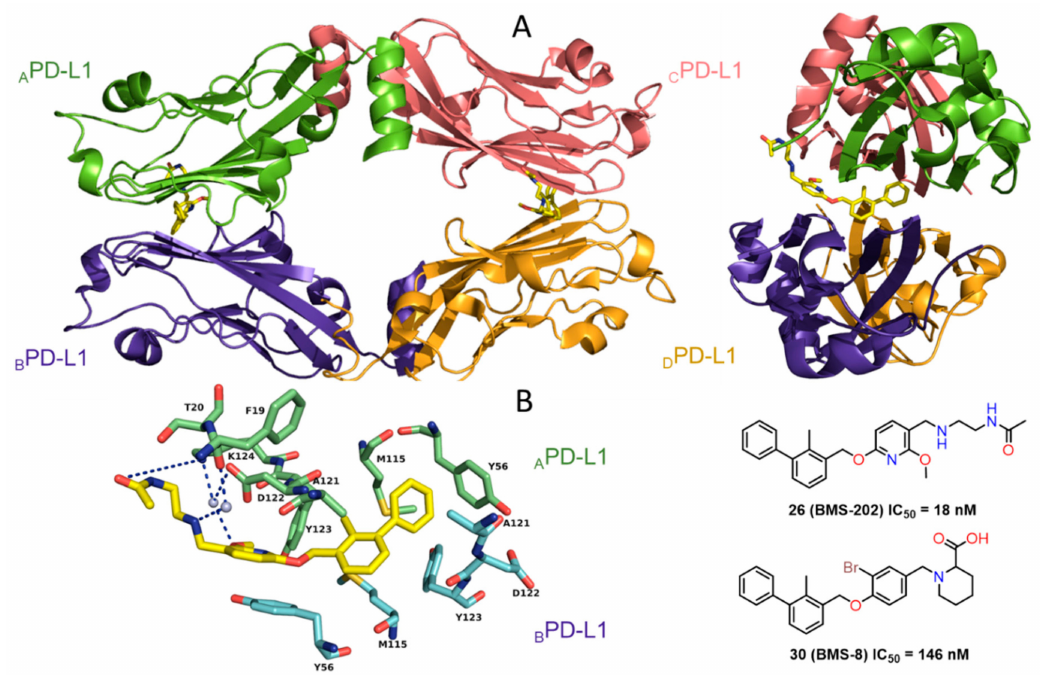
Figure 14. ( A ) Crystal structure of the 26 / PD-L1 complex. The asymmetric unit contains four molecules of PD-L1 (ribbon representation), which are organized into two dimers ( A PD-L1—green, B PD-L1—purple-blue, c PD-L1—salmon, D PD-L1—bright orange). Each dimer binds a single molecule of 26 (yellow) at the dimer interface. ( B ) Detailed interactions of 26 at the binding cleft of PD-L1 dimer. 26 binds at a hydrophobic cavity formed upon PD-L1 dimerization (PDB: 5J89). Compound 30 cocrystal structure is consistent with structural data for 26